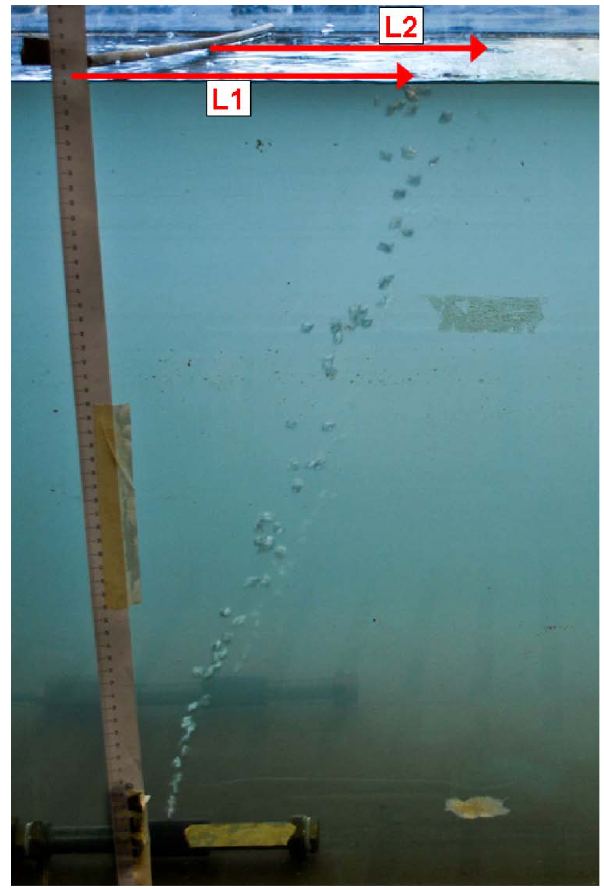
Fig. 4. Side view of the measurements in the laboratory flume; L 1 represents the horizontal displacement of bubbles originating from the nozzle located near the flume’s wall, L 2 of the ones from the nozzle located in the middle.